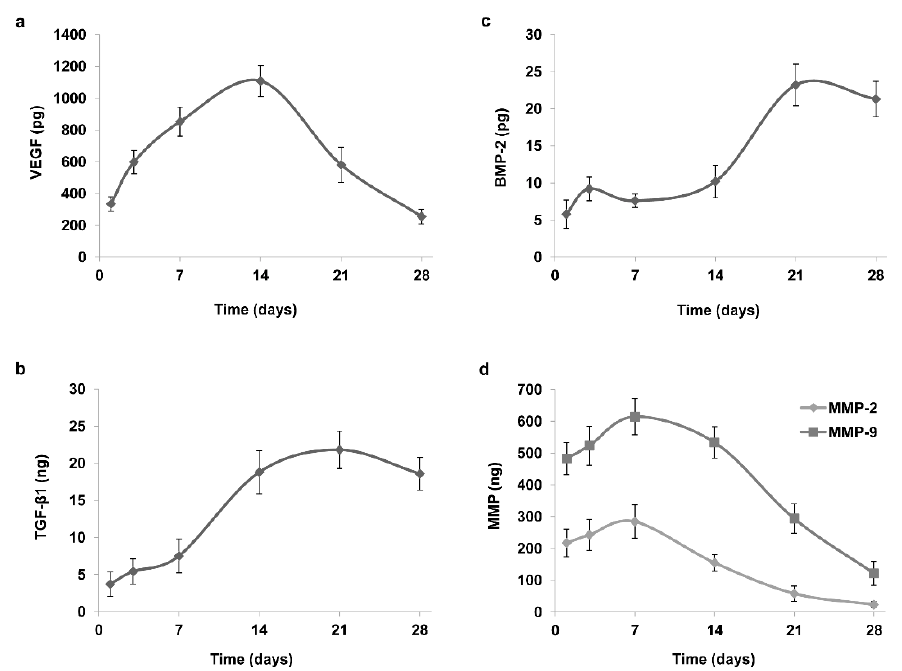
Figure 1. Growth factors and MMPs released by CGF. CGF clots were cultured in L-DMEM for a period of 0–28 days. At the appointed times (1, 3, 7, 14, 21, and 28 days), the conditioned medium was collected, and the growth factors ( a ) VEGF, ( b ) TGF- β 1, and ( c ) BMP-2 and ( d ) the matrix metalloproteinases MMP-9 and MMP-2 were quantified by ELISA. The results are expressed as the means ± SD of triplicate measurements from three independent experiments.